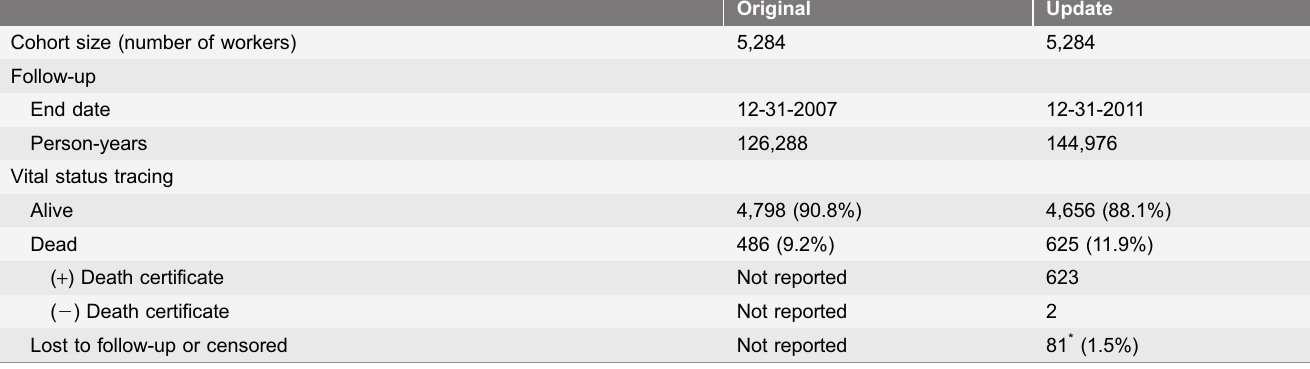
Table 1. Cohort size, follow-up, and results of vital status tracing in original study (Alexander et al.) and current